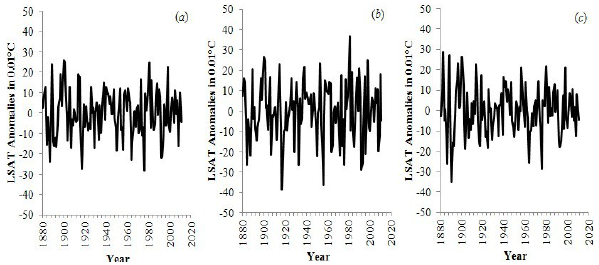
Fig. 2. Detrended annual mean LSAT anomalies in 0.01 ◦ C, during the period 1880–2011, (a) globally, (b) over the NH and (c) over the SH.